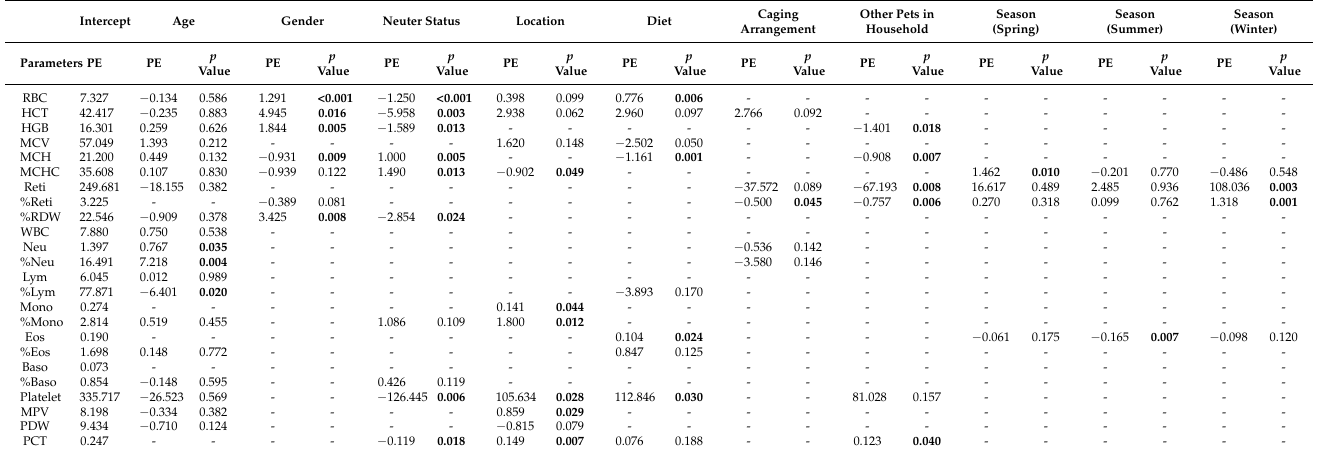
Table 5. Results of multiple regression models of hematological parameters.